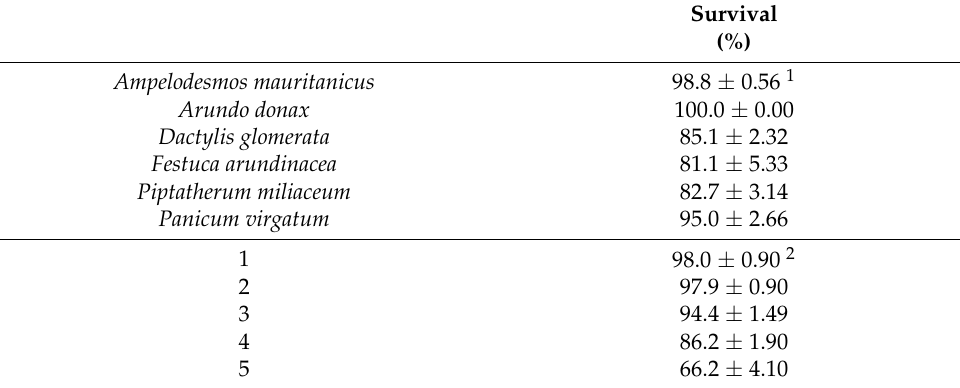
Table 3. Percentage of survival of the different perennial grasses assayed throughout the whole experiment and for the different growing seasons considering all the species tested together.